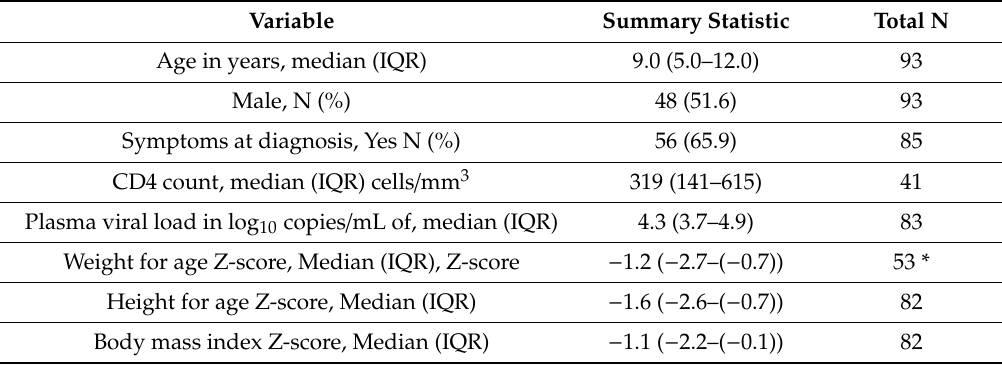
Table 2. Characteristics of children included in the